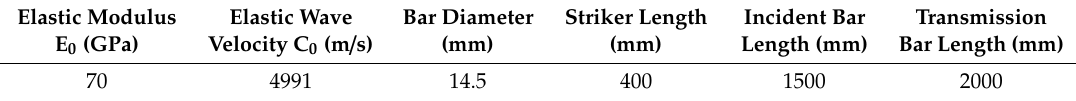
Figure 2. Schematic diagram of the SHPB experiment. Table 2. Detailed parameters of SHPB.